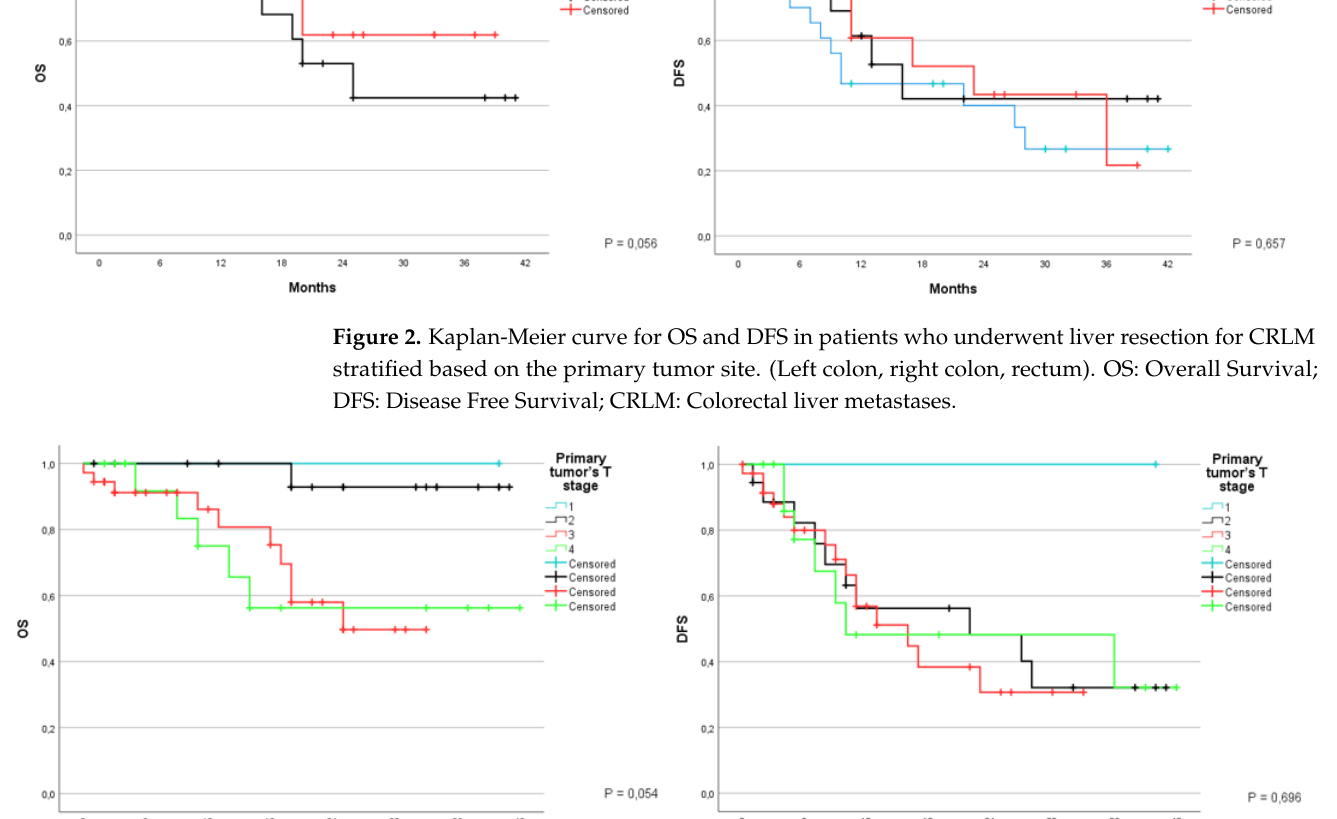
Figure 3. Kaplan-Meier Curve for OS and DFS in patients who underwent liver resection for CRLM stratified according to the primary tumor’s T stage. OS: Overall Survival; DFS: Disease Free Survival; CRLM: Colorectal liver metastasis.